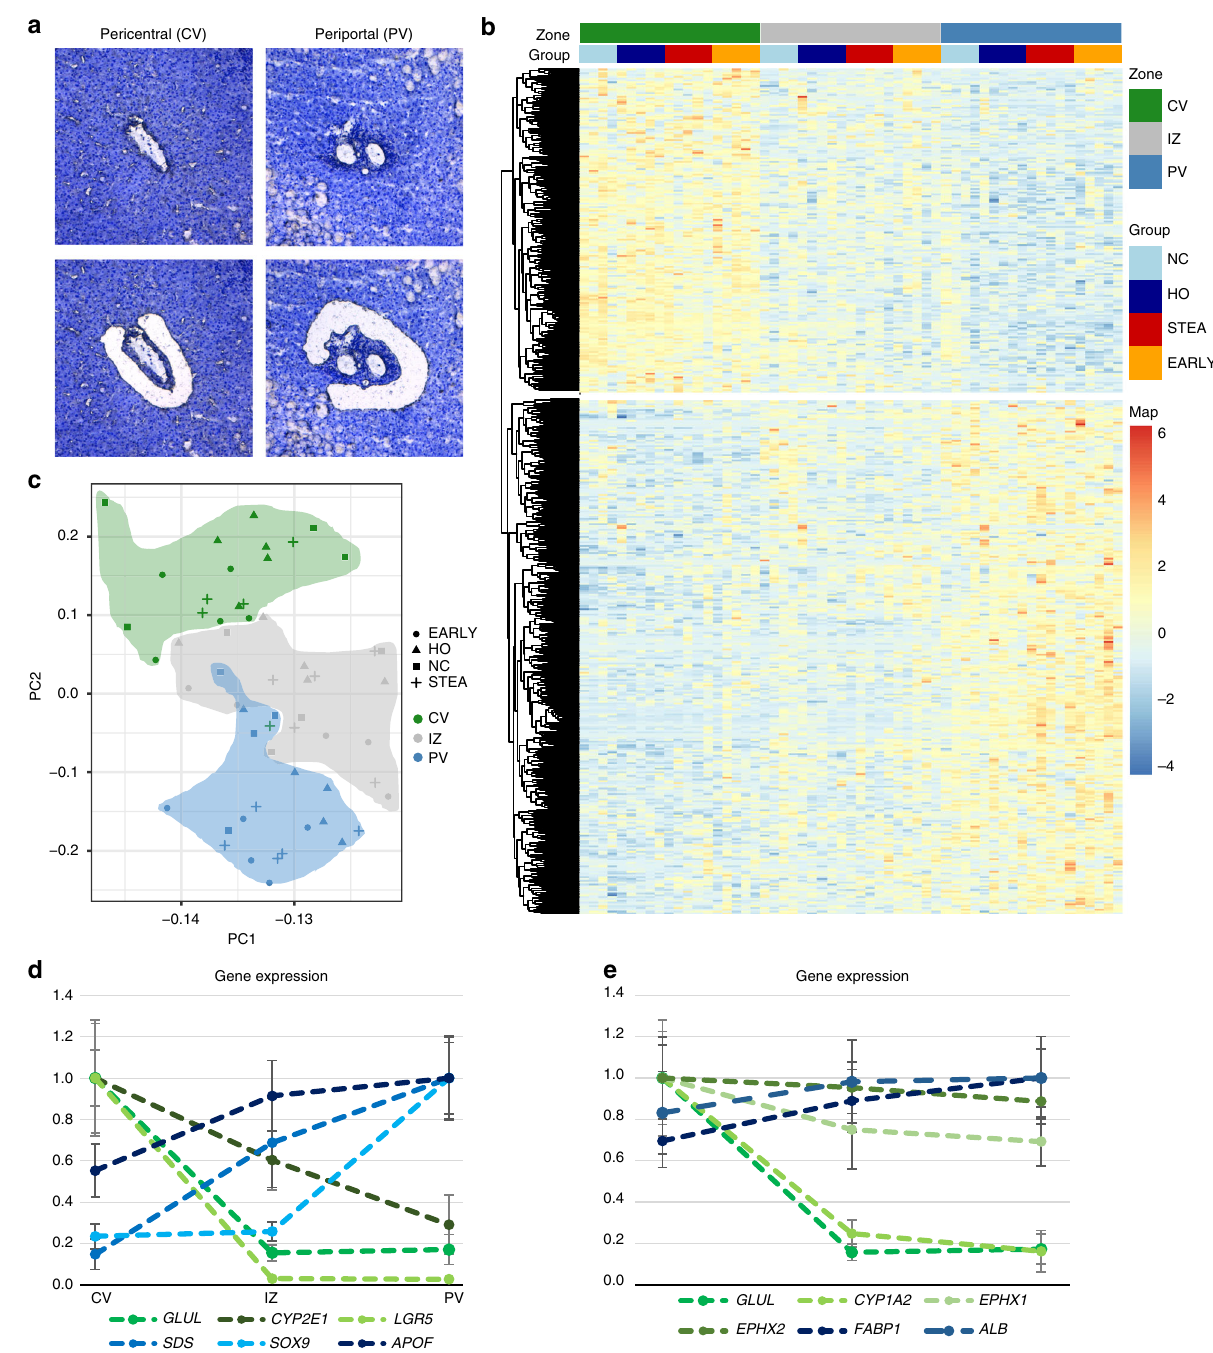
Fig. 1 Transcriptional zonation along the porto-central axis. a Representative image of laser microdissection of pericentral (CV) and periportal (PV) hepatocytes before LCM (upper images) and after LCM (lower images). b Principal component analysis of the 1000 most variable genes. Pericentral (PC) is coloured in green, the intermediate zone (IZ) in red and periportal (PV) in blue. Symbols correspond to phenotypic groups. c Expression z -scores of zonated genes at pericentral, intermediate and periportal zones ( N = 19). Zonated genes (805) were determined using edgeR with |log2FC|> 1 and FDR < 0.01 between pericentral and periportal samples and clustered by correlation. The annotation legend displays controls (NC) in light blue, healthy obese (HO) in dark blue, steatosis (STEA) in red and early NASH (EARLY) in orange. d Normalized expression (including standard deviation) of genes with previously described zonation in mouse liver in human pericentral, intermediate and periportal zones. Dashed lines are for visualization only. e Normalized expression (including standard deviation) of genes previously described as zonated in human liver in the CV, IZ and PV zones, based on immunohistochemistry and in situ hybridization for GLUL , ALB 17 , EPHX , CYP1A2 22 , CYP1A2 14 and FABP 14 . Dashed lines are for visualization